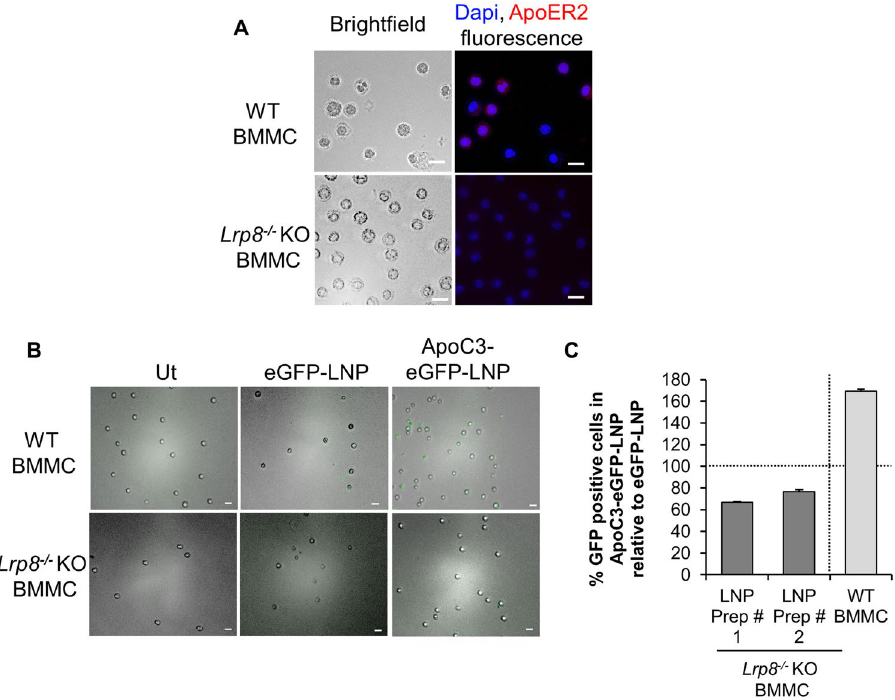
Figure. 6. ApoC3 failed to potentiate transfection in Lrp8 −/− KO compared to WT BMMC. ( A ) Cell surface expression of ApoER2 (red) in WT or Lrp8 −/− KO BMMC. Nucleus was stained with DAPI (blue). Left-hand side panel represents brightfield images and the right-hand side panel represents fluorescent image of the same field of view. Scale bar represents 20 µm. ( B ) transfection of eGFP-DODMA-LNP (eGFP-LNP) and ApoC3 complexed eGFP-DODMA-LNP (ApoC3-eGFP-LNP) in WT and Lrp8 −/− KO BMMC. Scale bar